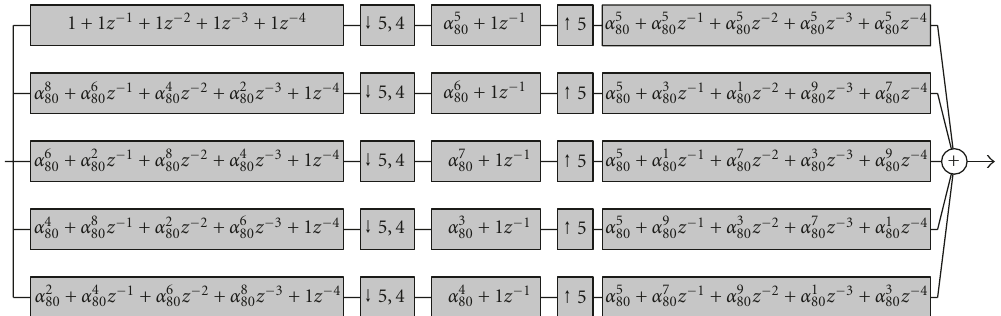
Figure 5: Critically subsampled filter bank representation over F q n of the BCH code B